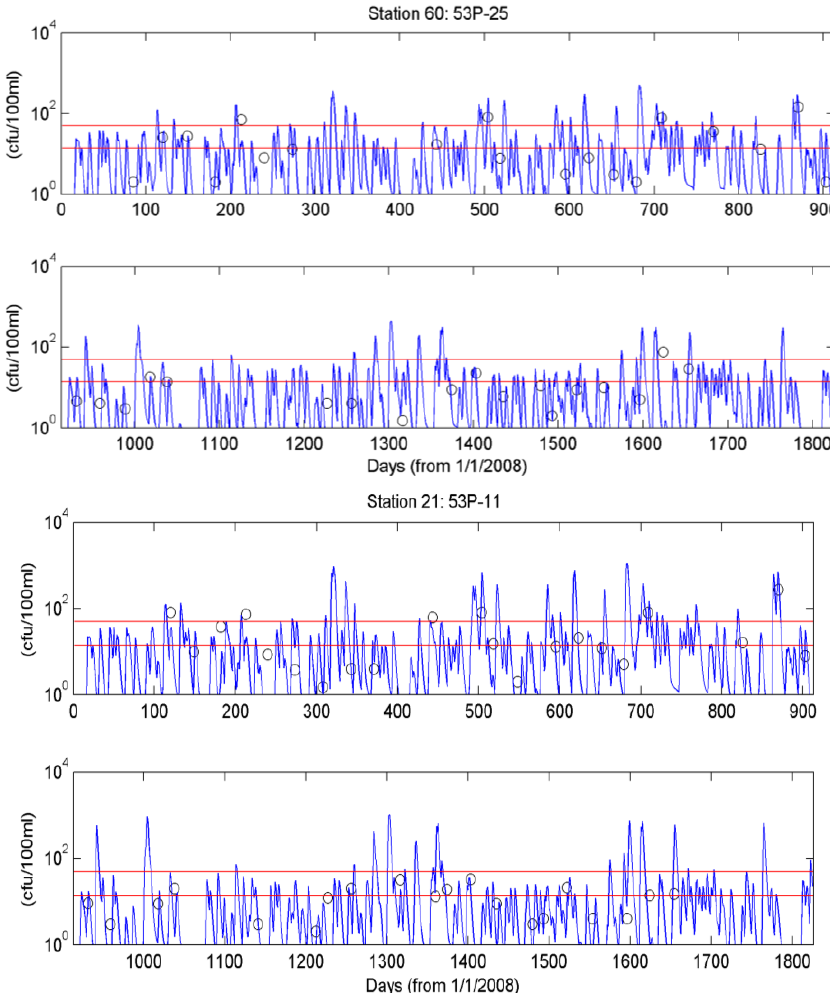
Figure 10. Comparison of model simulation of bacterial concentration and observation for the upstream of Poquoson River and Chisman Creek.